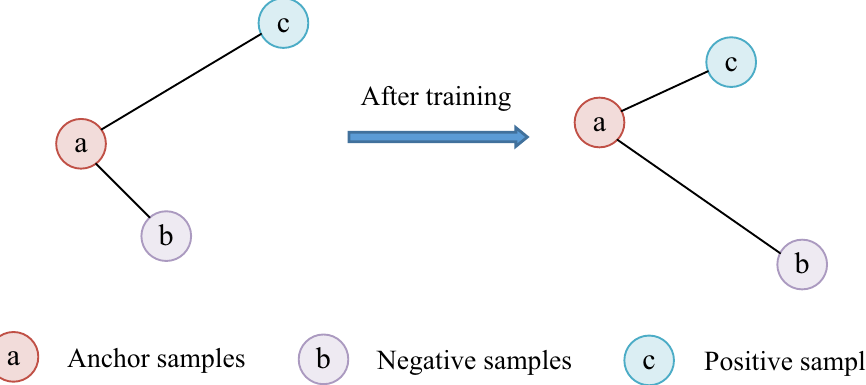
Figure 2. Triplet loss function for training, Euclidean distance as sample distance measurement. (Created by ‘Microsoft Office Visio 2013’ https:// www. micro soft. com/ zh- cn/ micro soft- 365/ previ ous- versi ons/ micro soft- vision-